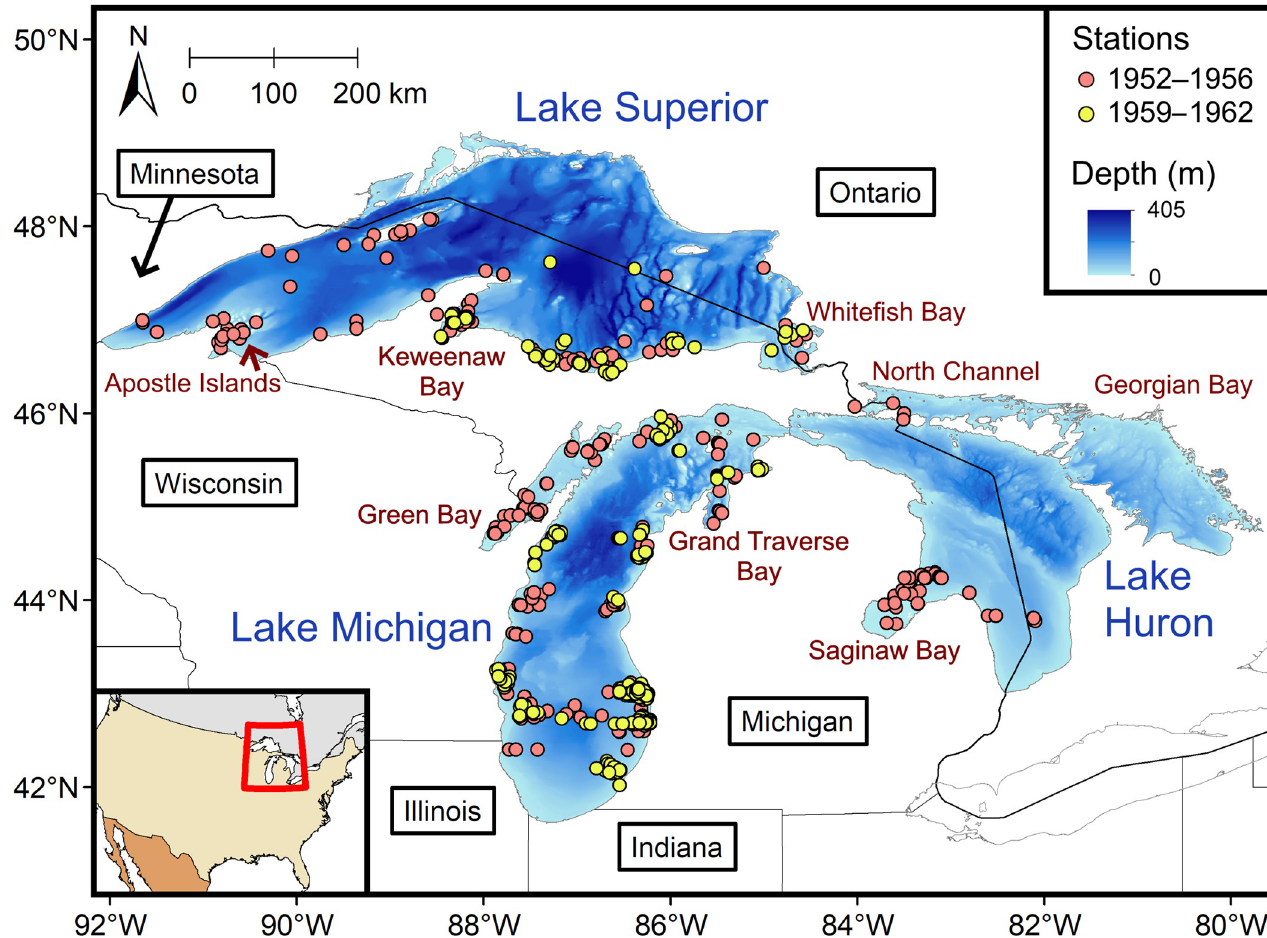
Fig 1. Upper Great Lakes map. Circles in different colors are the survey stations of the R/V Cisco , a research vessel of the U.S. Fish and Wildlife Service, in 1952–1956 and 1959–1962 in Lakes Superior, Michigan, and Huron. The map was generated with geographic information system (GIS) software ArcGIS version 10.8 (http://www.esri.com/software/arcgis/). The GIS layers for the survey stations were generated in this study. The GIS layers for the Great Lakes bathymetry and polygons were obtained from the Great Lakes Aquatic Habitat Framework’s [17] public domain spatial database (https://glahf.org/data/). The GIS layers for political boundaries were obtained from another public domain spatial database Natural Earth (https://www.naturalearthdata.com).